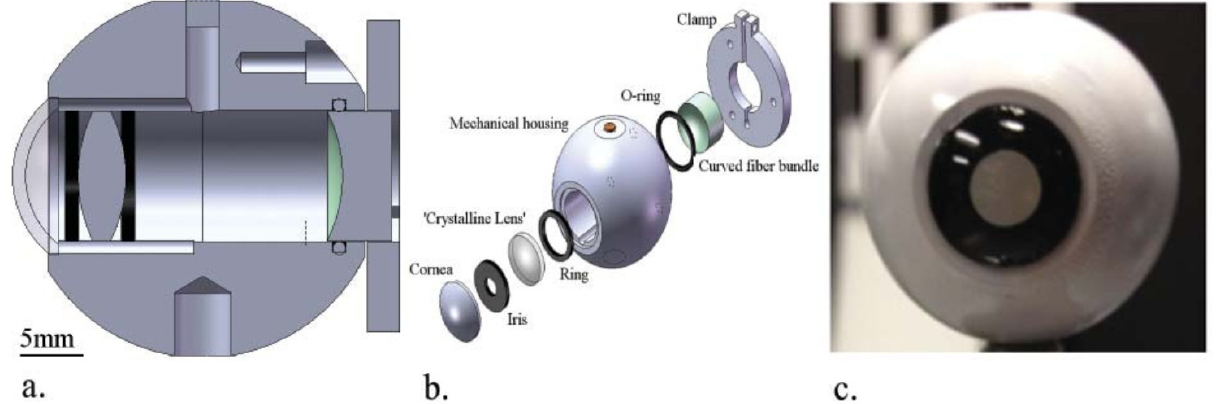
Figure 17. Eye model used by Arianpour et al. ( a ) Cross-sectional view of the optomechanical eye model. ( b ) Exploded view with the individual parts listed. ( c ) The assembled optomechanical eye model that is comparable to a life-size human eye. Journal of Refractive Surgery 2013;29(2):126–132 ([46]). Originally published by and reprinted with permission from SLACK Incorporated.